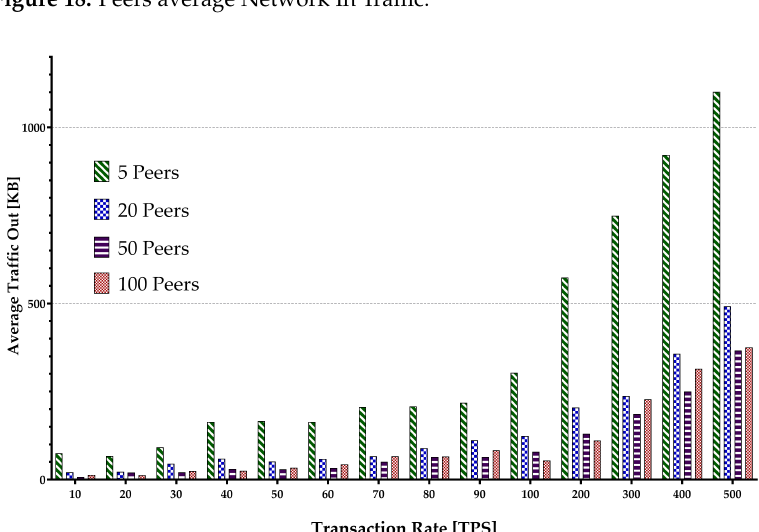
Figure 18. Peers average Network In Traffic.